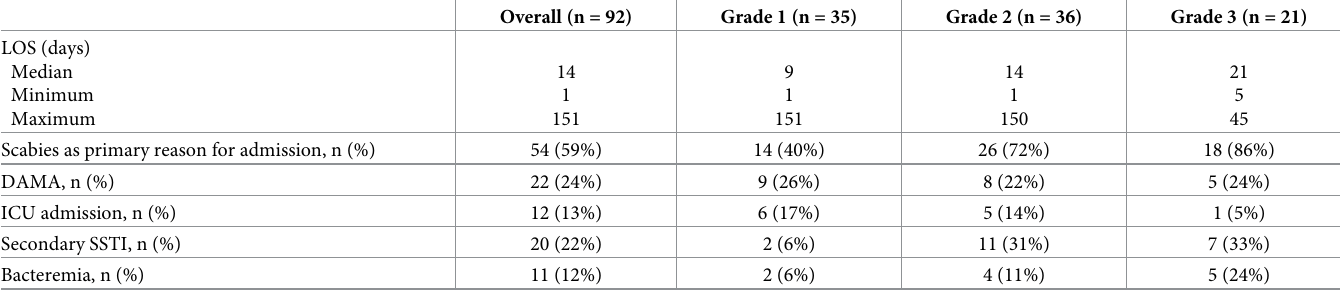
Table 2. Characteristics of hospital admission.